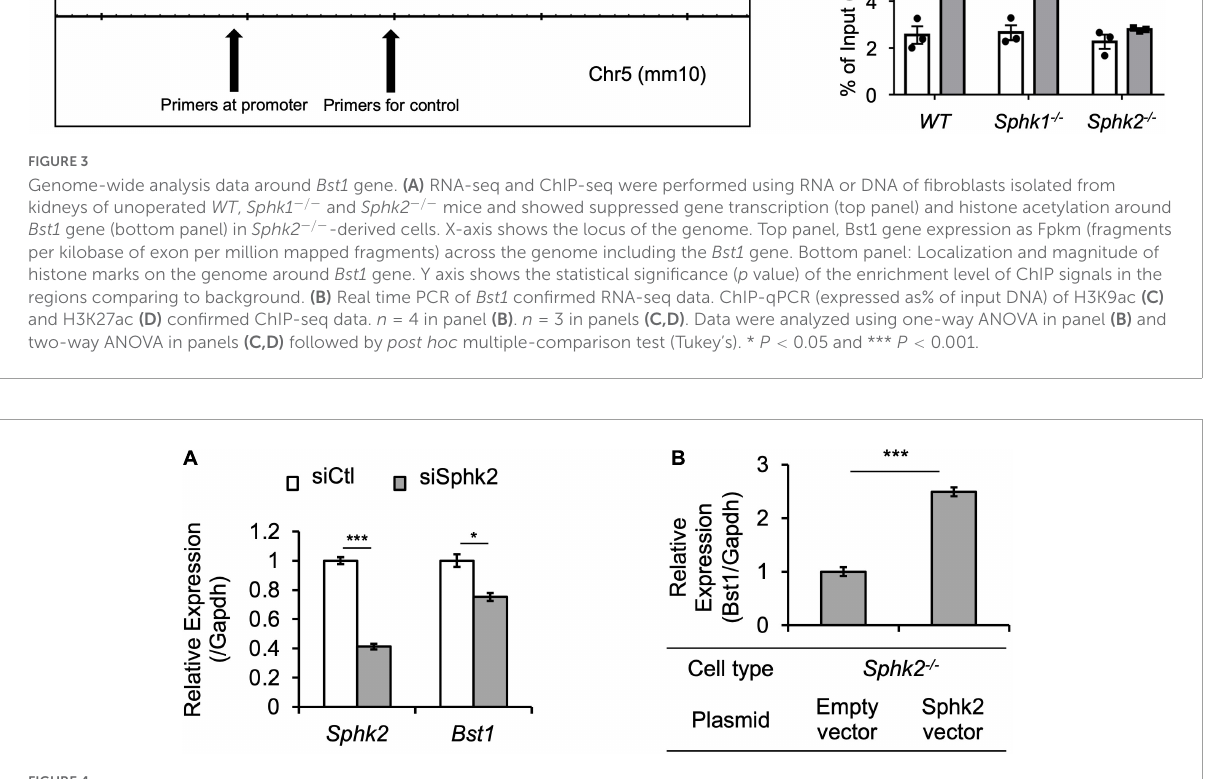
FIGURE4 SphK2 regulates Bst1 expression. (A) si Sphk2 suppresses Bst1 expression in Sphk2 + / + fibroblasts. (B) SphK2 overexpression rescues Bst1 expression in Sphk2 − / − fibroblasts. n = 3 each in panels (A,B) . Data in panels (A,B) were analyzed with Student’s t -test (2 tailed). * P < 0.05 and *** P < 0.001. siCtl, control